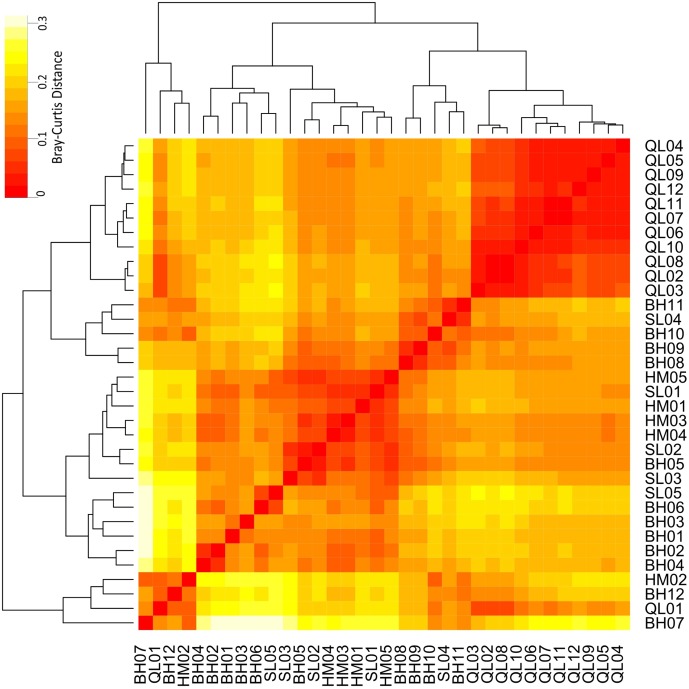
Heatmap showing the functional differences of microbial communities between streams and Qinghai Lake based on Bray–Curtis distance. Bray–Curtis distances were calculated using relative abundances of PICRUSt predicted KEGG orthologies (KOs).